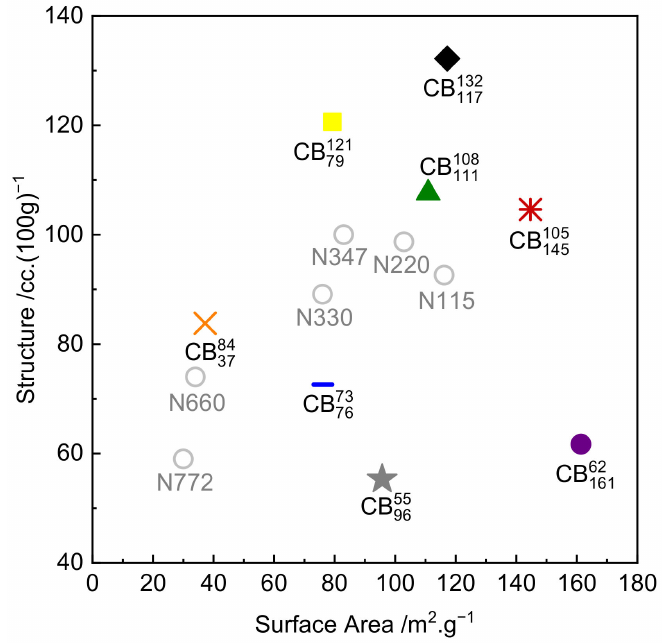
Figure 1. Colloidal plot of tested carbon blacks, with commonly used carbon black grades for reference (open